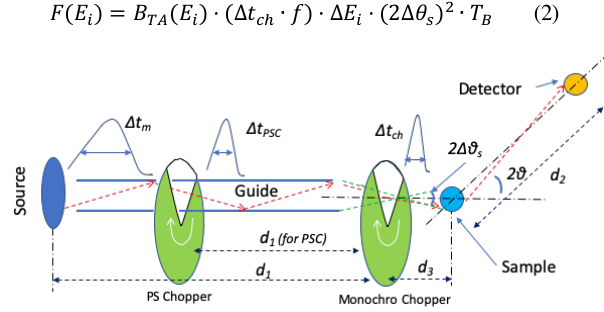
Fig. 2. Layout of a multi-chopper instrument. In case for a long pulse or a reactor source, a pulse shaping chopper (PSC) sharpens the pulse. And monochromatic chopper defines Ei in any sources.